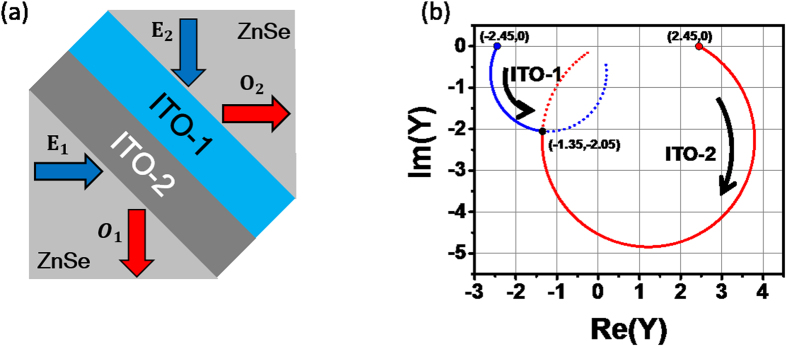
(a) Schematic diagram of broadband CPA device [ZnSe|ITO-1|ITO-2|ZnSe] and (b) modified admittance diagram of [ZnSe|ITO-1(14.22nm)|ITO-2(20.13 nm)|ZnSe] at 1550 nm in wavelength and with 45° incident angles, where NITO−1 = 0.27 − i0.84, NITO−2 = 0.59 − i0.30, and nZnSe = 2.45 were used.